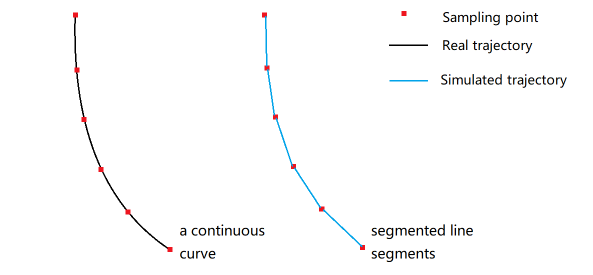
Figure 4. Real trajectory and simulated trajectory of fast